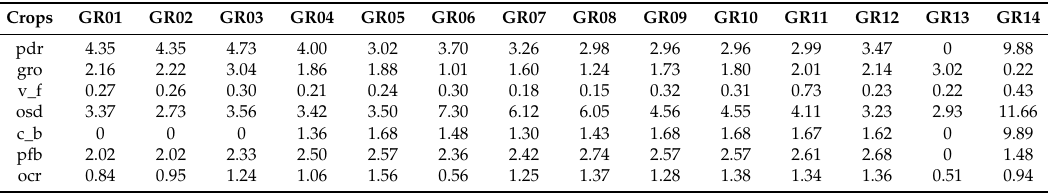
Table 4. Exported virtual crop water per value ratio for all crop types and all RBDs in Greece for base year 2011 (in m 3 of virtual crop water per USD). Shaded cells represent the lowest values. Crops